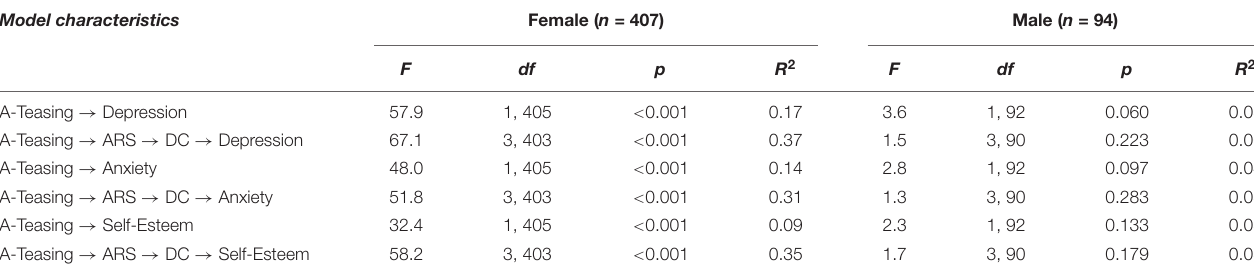
TABLE 4 | Comparison of gender-specific model indices for the total effect and serial mediation models in the female and male subgroups. Model